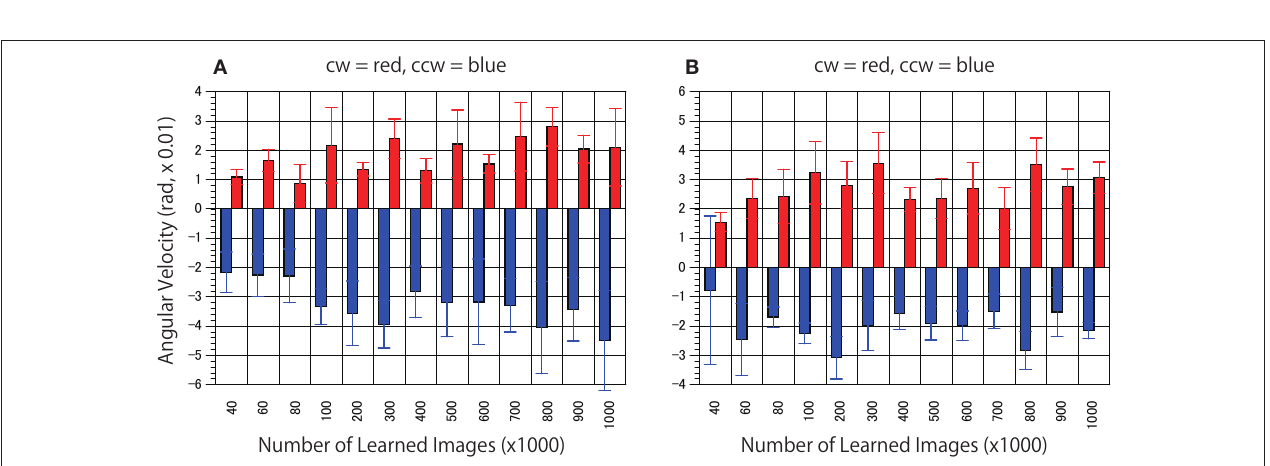
FIGURE 4 | Predicted motion found in the rotating propellers. (A) Optical flow vectors detected between a pair of the first/second consecutive predictive images (P1/P2) of the rotating propellers (15 rpm). (B) Mirrored images of the rotating propellers were used as test stimuli. In other words, the cw of A and the ccw of B are derived from the same video, and the ccw of (A) and the cw of ( B) are derived from the same video. Six optical flow vectors were detected in each pair of predicted images. Mean angular velocity was calculated from the optical flow vectors. A positive sign was assigned to clockwise rotation. The results of the clockwise propeller are presented in red, and the results of the counter-clockwise propeller are presented in blue. The rotation rate of 15 rpm is approximately comparable to 5.23rad ( × 0.01). Error bars indicate standard errors, and the slanted zero horizontal lines appear to a kind of café wall illusion.